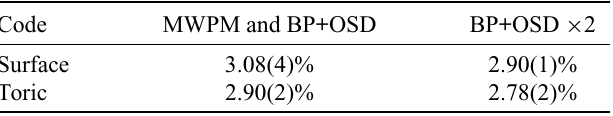
TABLE II. Sustainable thresholds for 3D toric and surface codes for different single-shot decoding strategies. For each entry in the table, we did an analogous simulation to that described in Fig. 1. The numbers in brackets are the standard